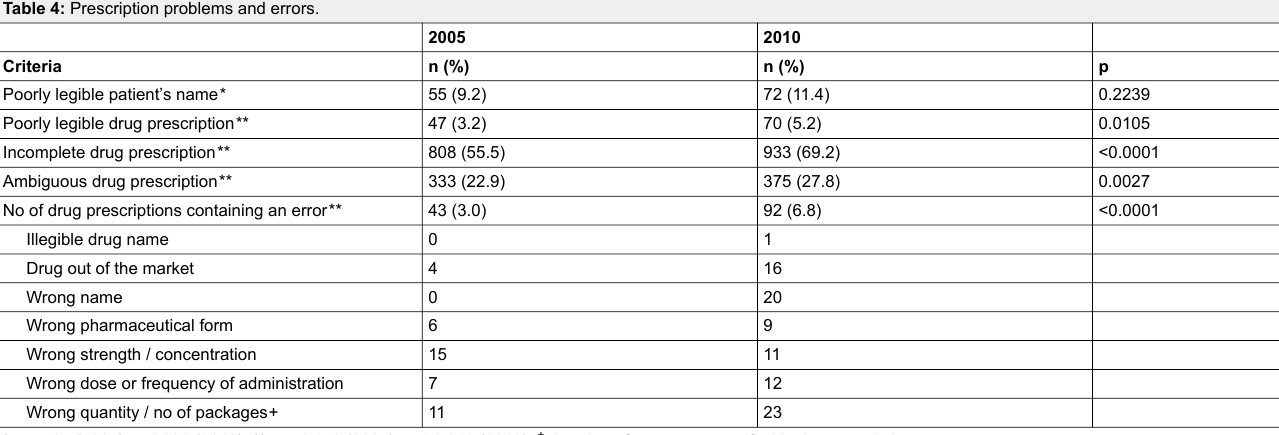
Table 4: Prescription problems and